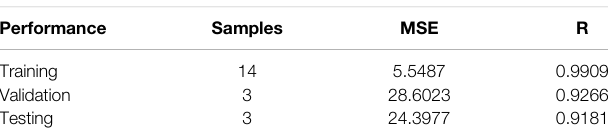
Supplementary Figure S2 . The LM back propagation highlights